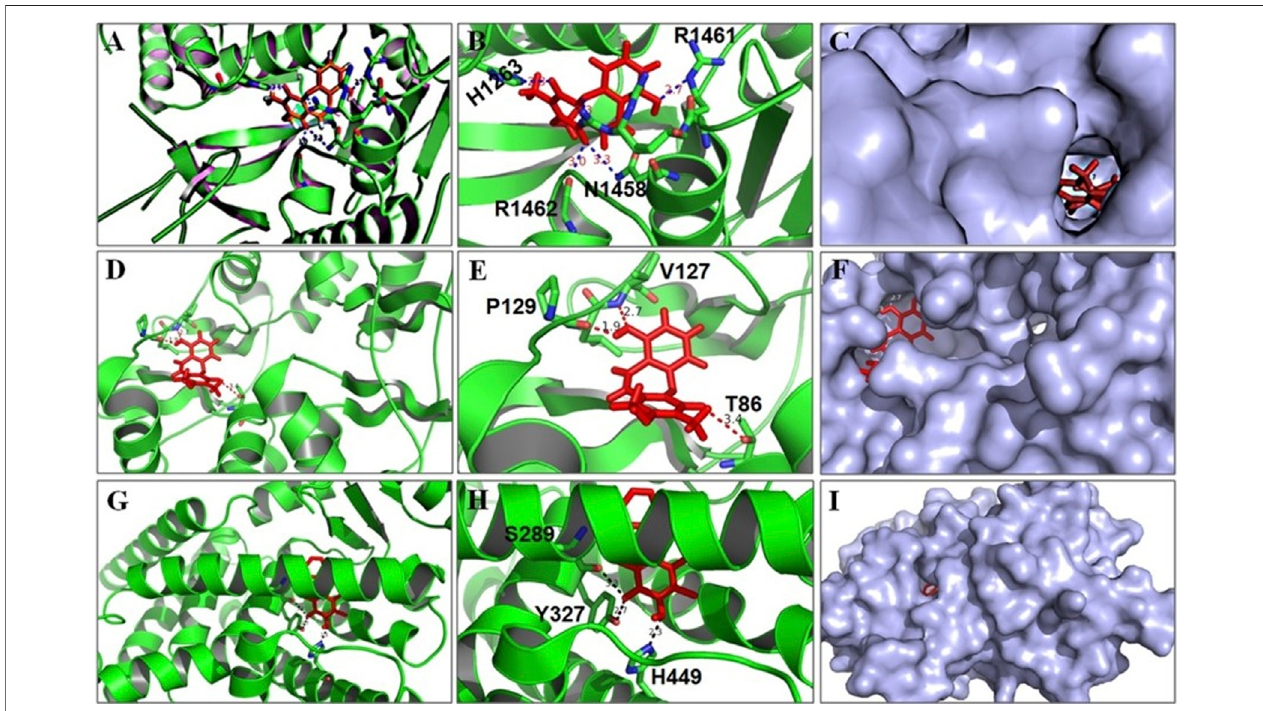
FIGURE 7 | BSTN1 docking to FAS, AMPK and PPAR- γ . (A − C) Computational docking of BSTN1 (red) with the FAS (6NNA). (D − F) Computational docking of BSTN1(red)withtheaminoacidsoftargetingAMPK(6C9F). (G − I) ComputationaldockingrevealsthatBSTN1(red)stronglyinteractswithhydroxylandaminogroupsof the tyrosine, serine and histidine residues of PPAR- γ (3WMH). FAS, fatty acid synthase; AMPK, AMP-activated protein kinase and PPAR- γ , peroxisome proliferator- activated receptor- γ